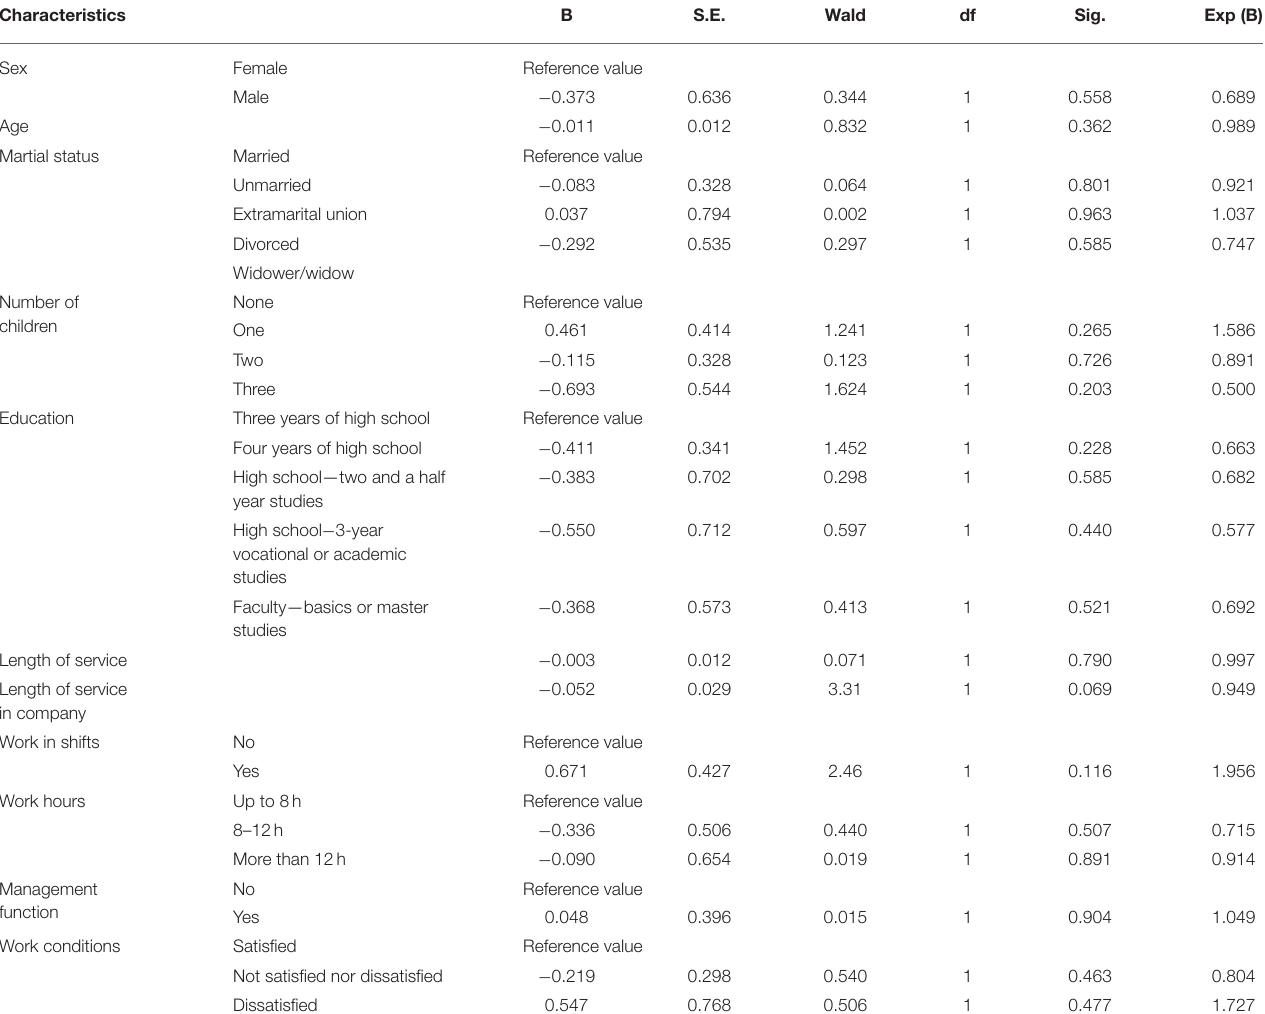
TABLE 5 | Factors affecting the DP variable: results of multiple regression analysis.